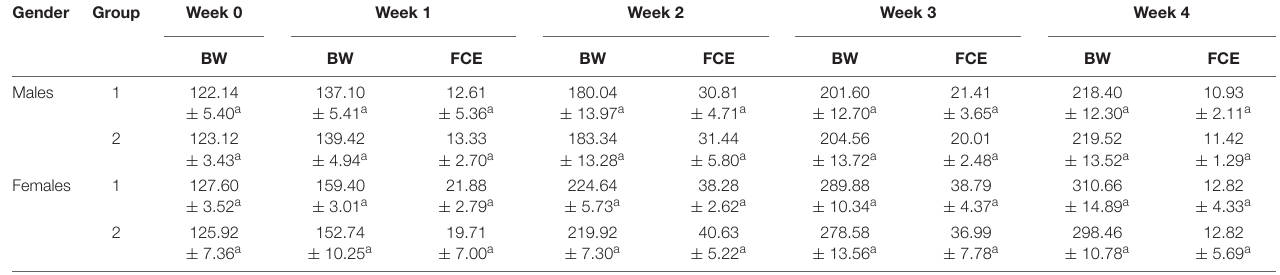
TABLE 2 | Body weight and food conversion efficiency in SD rats administered for 4 weeks. Gender